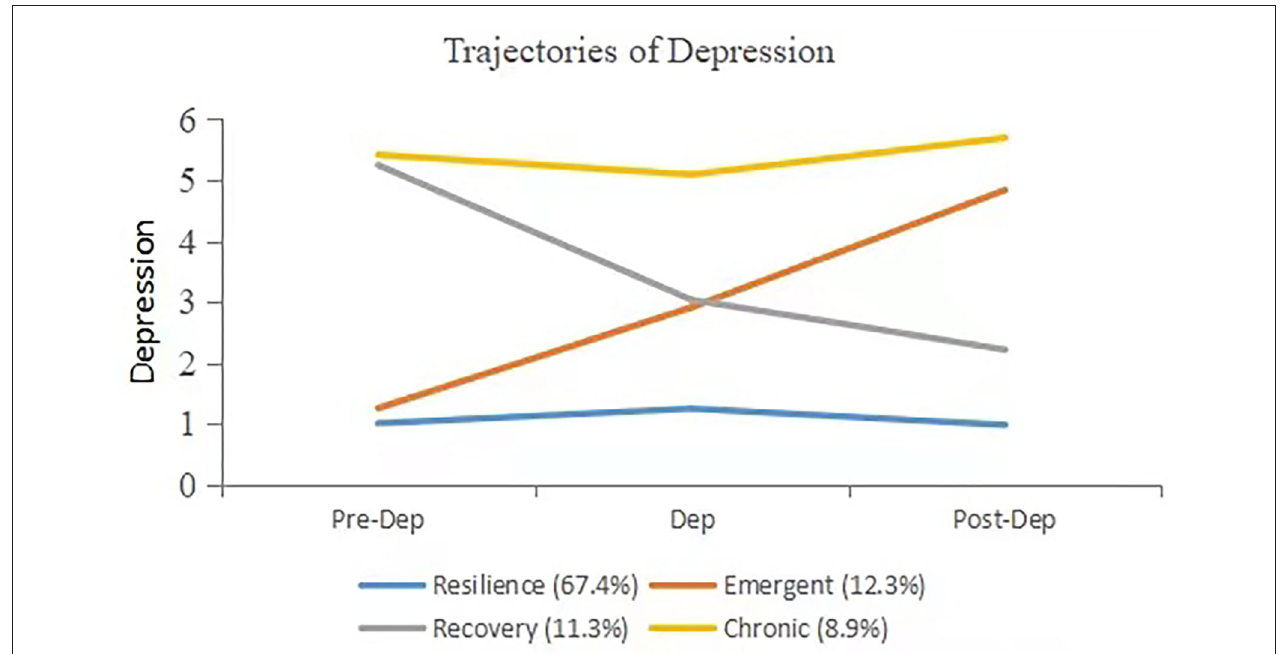
FIGURE 1 | Best fitting latent growth mixture model for depression in stroke patients. Pre-dep, pre-stroke depression; Dep, depression; Post-dep, post-stroke depression.